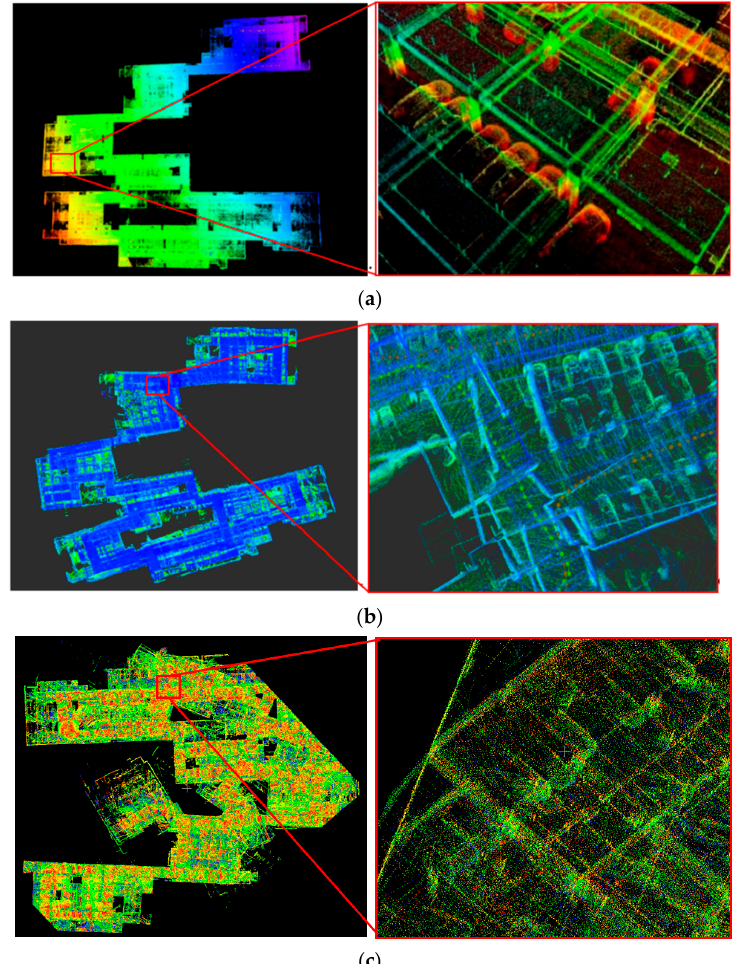
Figure 9. The 3D point cloud map reconstructed by three different algorithms. ( a ) The 3D point cloud map is constructed by our algorithm; ( b ) the result is obtained by the traditional optimization algorithm with interframe alignment and closed-loop optimization and ( c ) the result is obtained by the algorithm with interframe point cloud association and subgraph association .